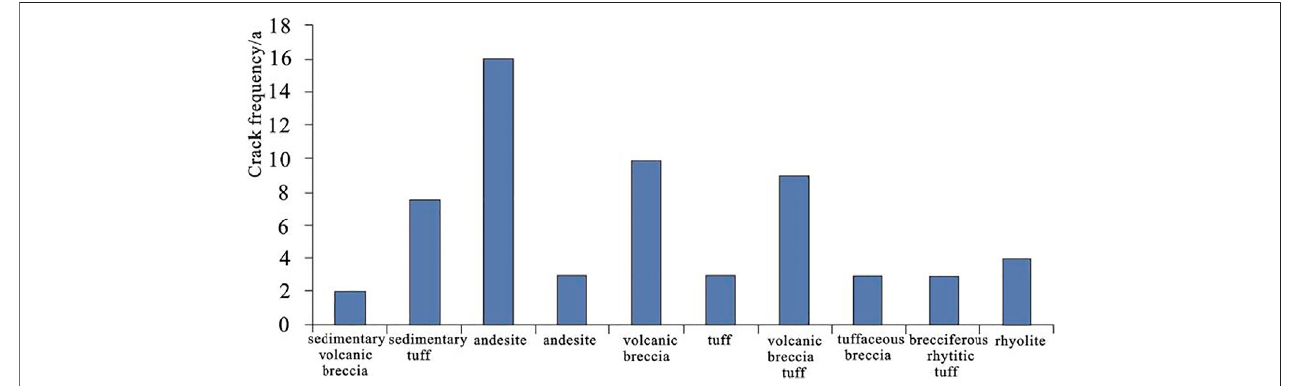
FIGURE 15 | Development frequency of structural fractures with different lithology in Mesozoic of D Oil fi eld.